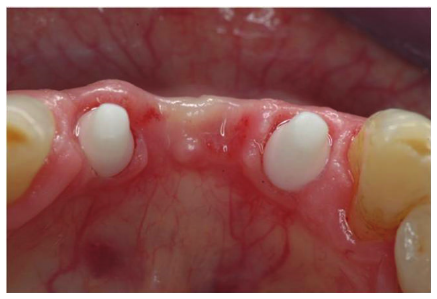
Figure 8: Occlusal view.